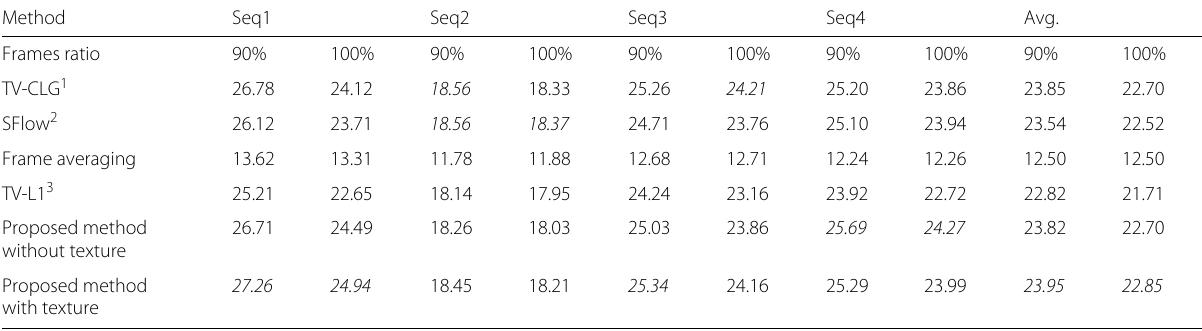
Table 1 Average PSNR for 90 and 100% of test sequences